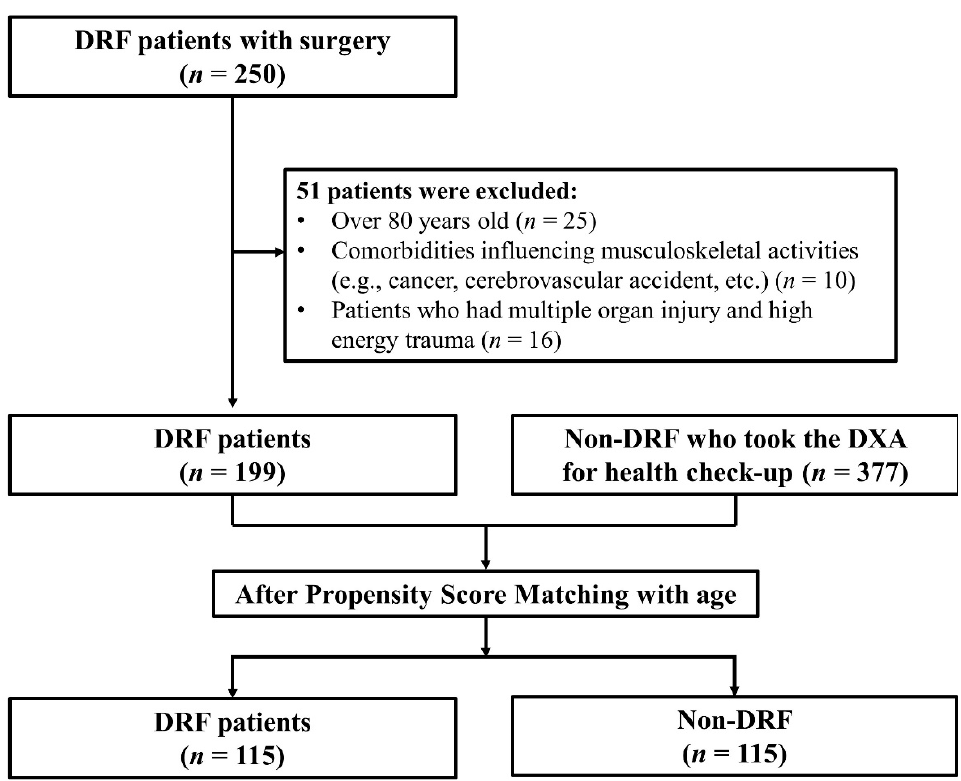
Figure 1. DRF: distal radius fracture, DXA: dual-energy X-ray absorptiometry. Variables included sex; age; BMI; T-score from BMD; the presence of